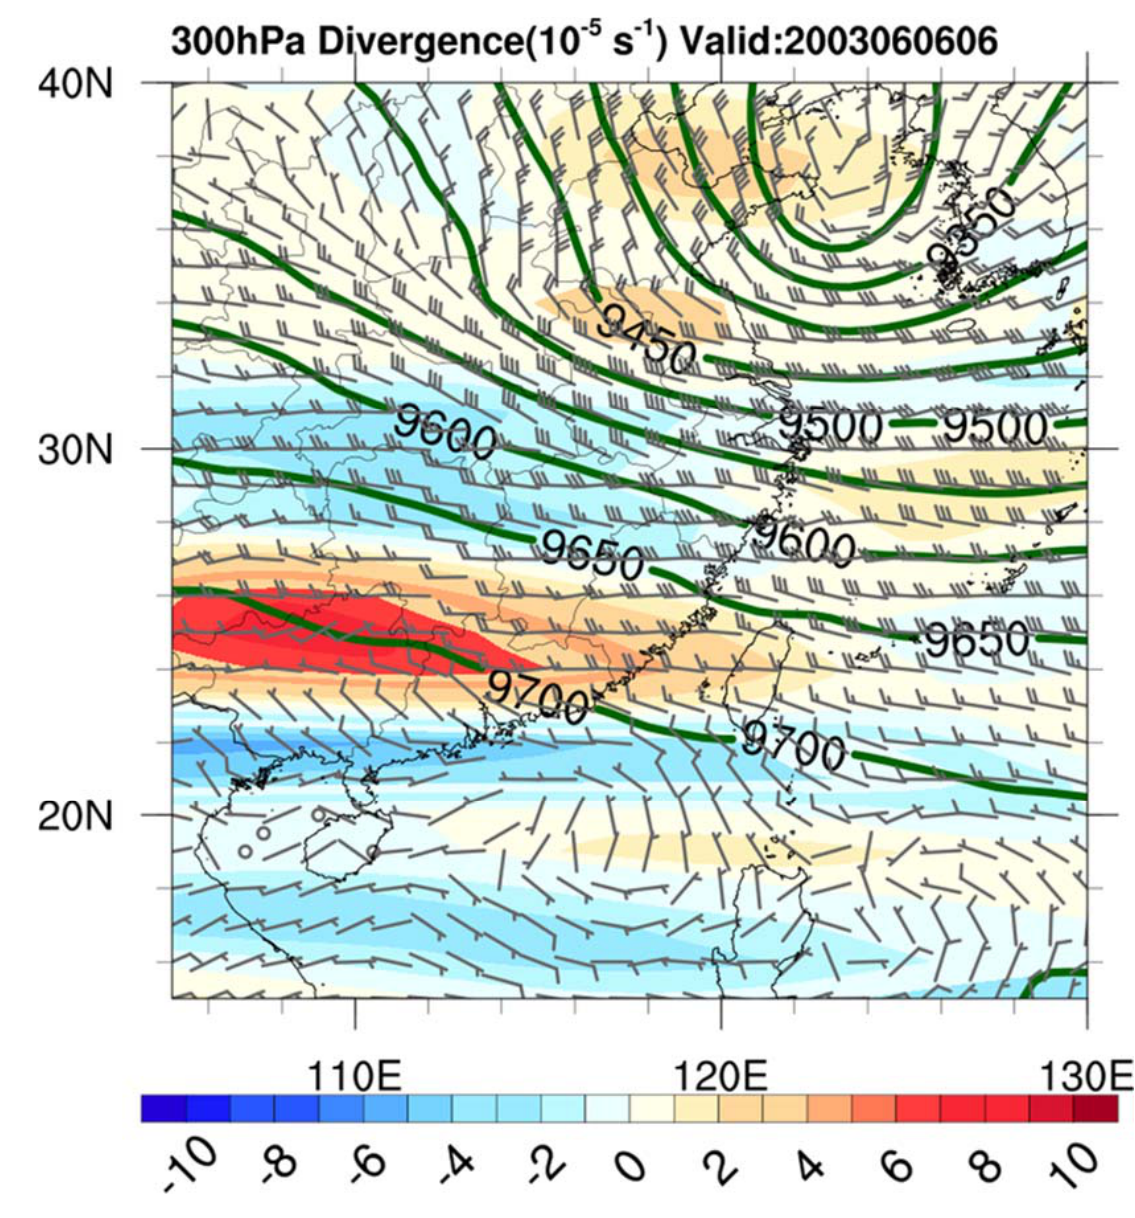
Figure 9. The CFSR divergence at 300 hPa (10 − 5 s − 1 ), winds ( V ; m s − 1 , full barb and half barb represent 10 and 5 m s − 1 , respectively), and geopotential height (gpm, dark green lines) at 0600 UTC (1400 LT) 6 June 2003.